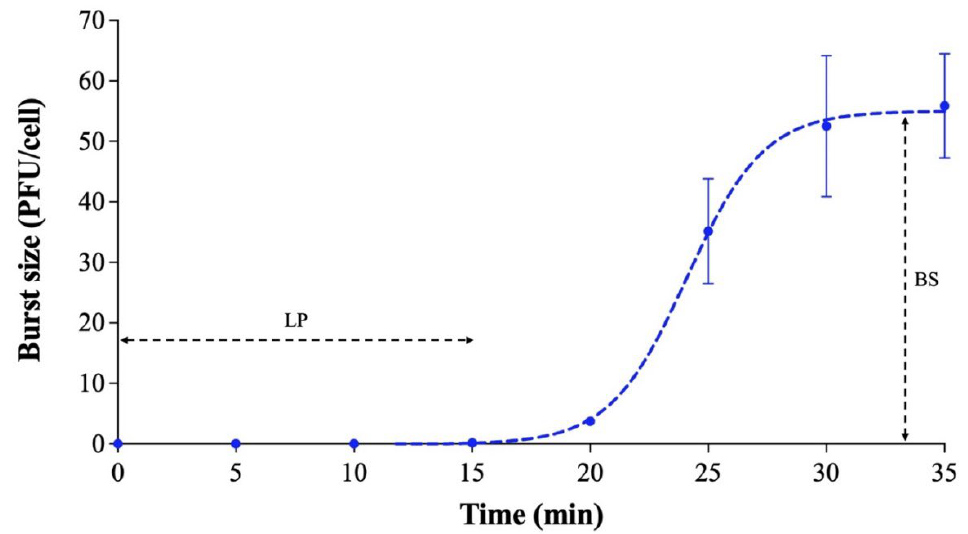
Figure 5. One-step growth curve of phage Ro45lw using generic E. coli O45:H- strain (RM10729). The growth parameters of the phage indicate a latent period (LP) of 15 min and an average burst size (BS) of 55 phages per infected cell. The error bars present the standard error of the mean (SEM) for each time point of the one-step growth curve.